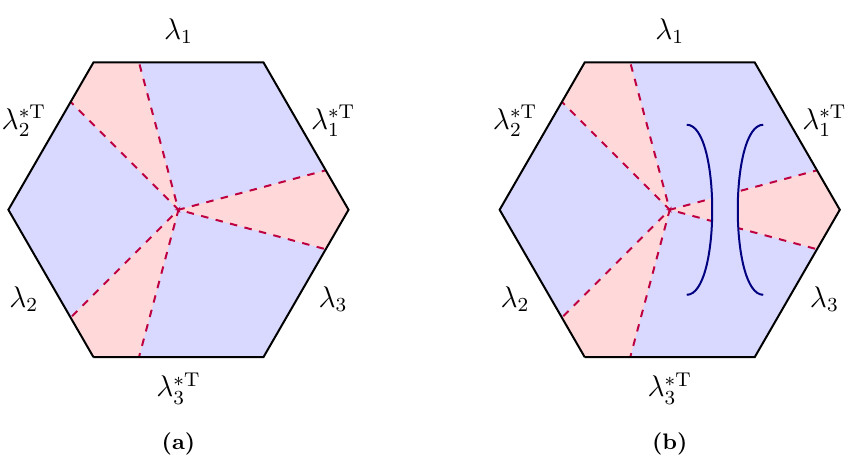
Figure 5. The partition function Z [ λ n , . . . , λ 1 ] should be computed on manifolds f M n with ( n ) the boundary conditions shown (the case shown is for n = 3 ). The n gravitational regions are disconnected in (a) , and this is what we would do in an ordinary QFT. However, since this is a theory of gravity, we should allow all topologies in the gravitational regions, including those which connect various copies with wormholes, for example like in (b)